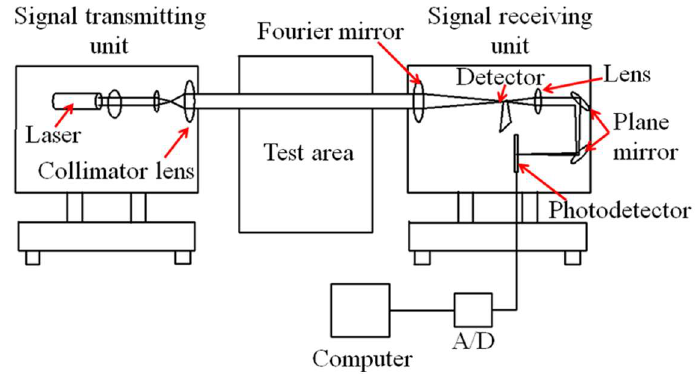
Figure 7. Measurement of the atomization parameters.